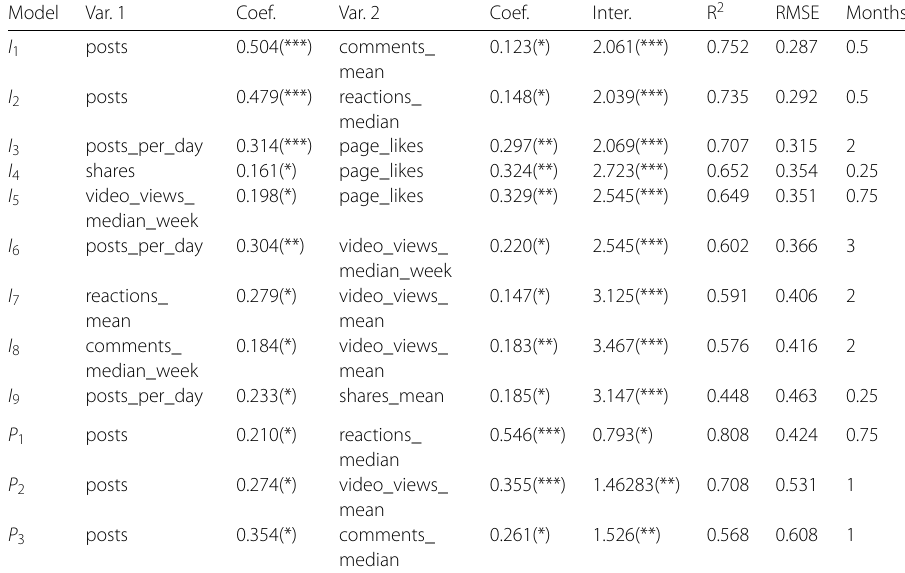
Table 3 Best performing models Model